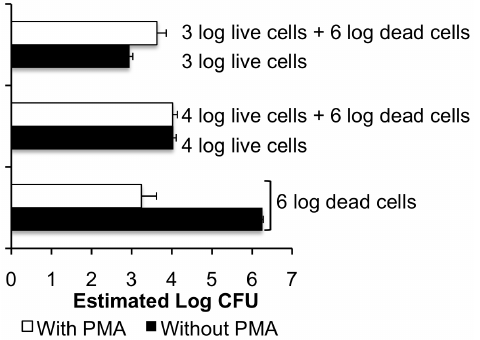
Figure 2. Interference of dead cells in the enumeration of live E. coli O157:H7 by PMA real-time PCR. Cell amounts were quantified by real-time PCR (total; black bars) or PMA real-time PCR (viable; open bars) in mixtures of 10 3 or 10 4 live cells mixed with 10 6 isopropanol- inactivated dead cells. Samples were treated with 40 m M PMA for 30 min. Estimates of E coli O157:H7 cell amounts were based on comparisons to standard curves constructed using E. coli O157:H7 ATCC 700728 genomic DNA. Each bar represents the mean 6 stdev for three independent replicates.